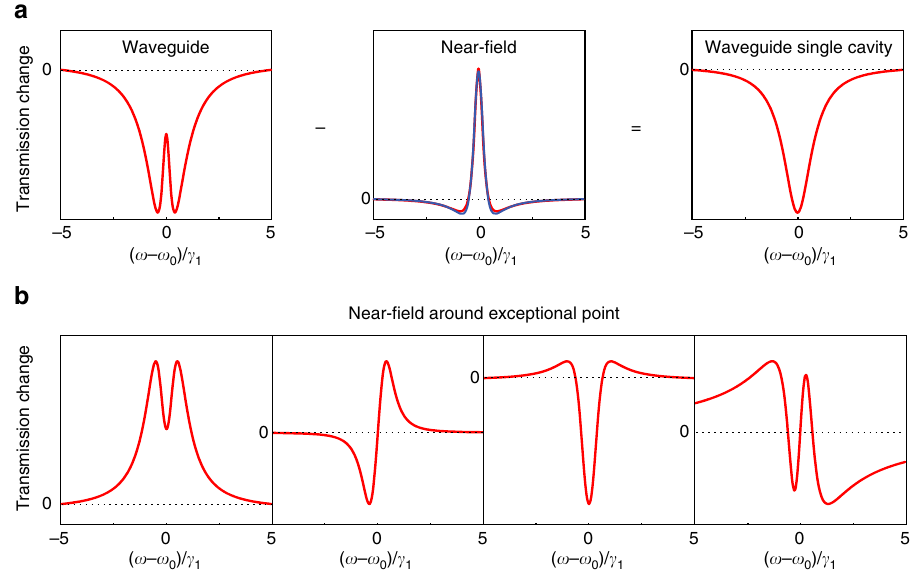
Fig. 2 Generalized Fano lineshapes calculation. a The difference between the pro fi les obtained by the waveguide and near- fi eld models, for κ = 0.8 κ 0 and γ γ = 10, as reported in Fig. 1b and e, gives rise to a Lorentzian dip corresponding to the transmission of the waveguide coupled to a single-cavity system. 1 / 2 The near- fi eld generalized Fano pro fi le (central red line) is reproduced by Eq. (1) (blue line) with the fi t output parameter q = − 1. b Four representative generalized Fano lineshapes obtained by the near- fi eld model using Supplementary Eq. (61) close to the EP. They show 0, 1, 2, and 3 zero-crossing with the zero-value baseline,